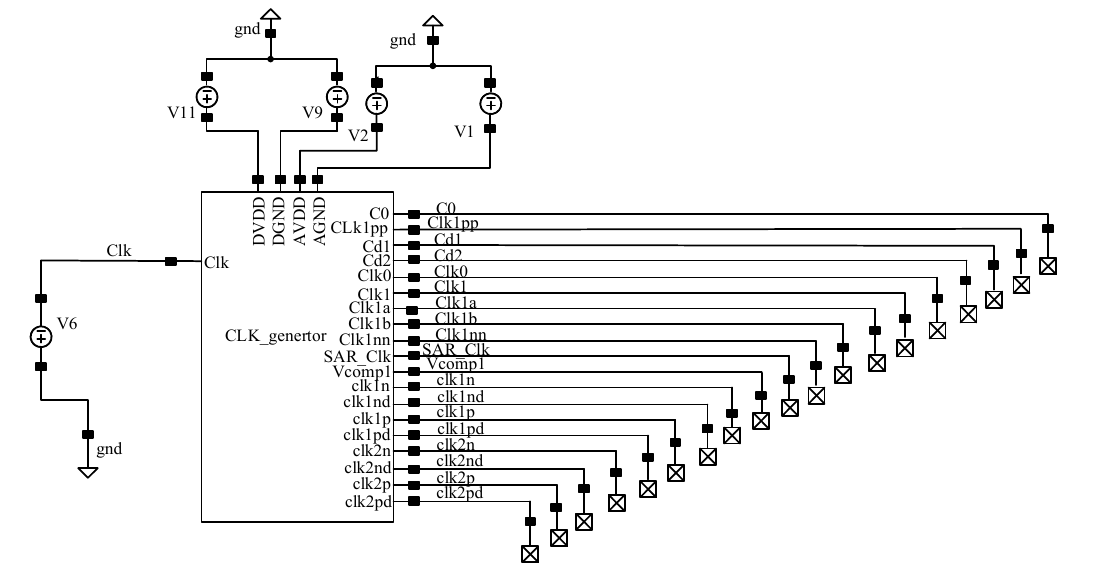
Figure 8. Clock circuit simulation design.